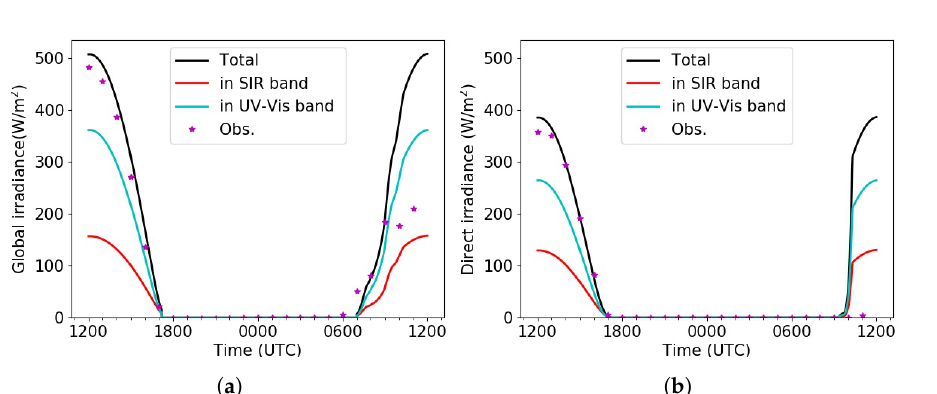
Figure 2. Comparisons, at the earth surface, between observations and simulation of global solar ( a ) and direct solar ( b ) irradiances for the SIR, UV-Vis and total (SIR+UV-Vis) bands. Although the influence of aerosols on downward and upward fluxes is taken into account for both UV-vis and SIR bands, the heating rate in clear sky is largely dominated by the SIR band (Figure 3).